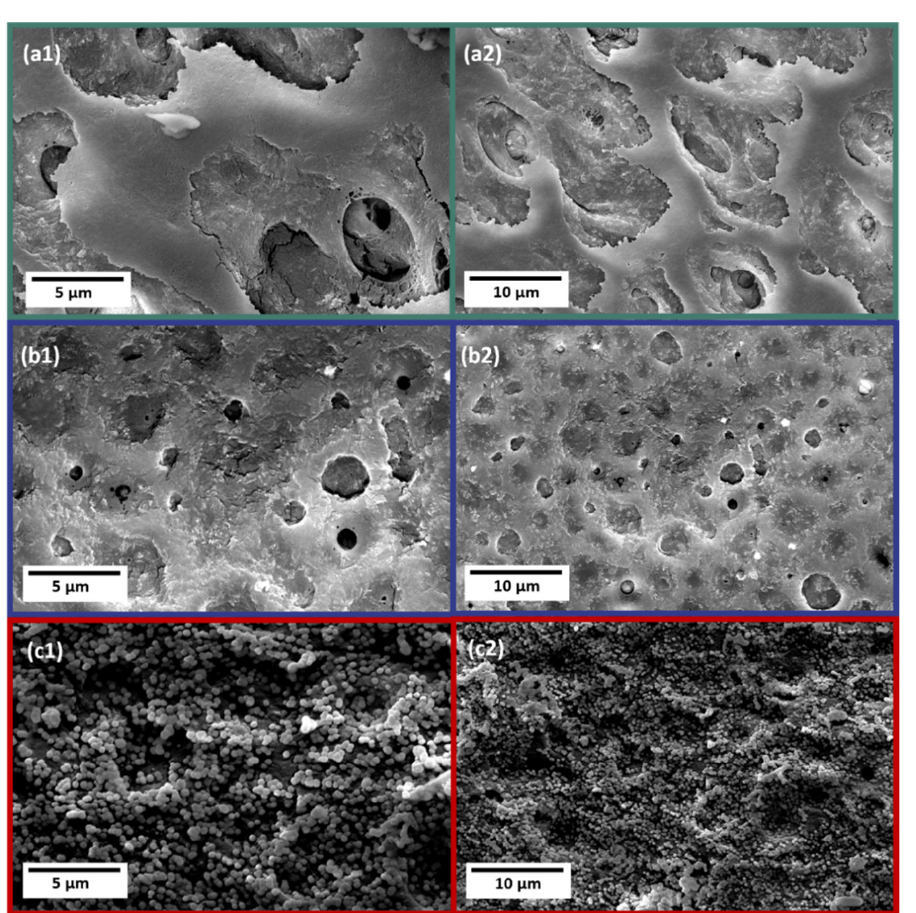
Figure 1. Scanning electron microscopy images of surfaces of cellulose acetate (CA) ( a1 , a2 ), CA7dSrP ( b1 , b2 ), and CA14dSrP ( c1 , c2 ).